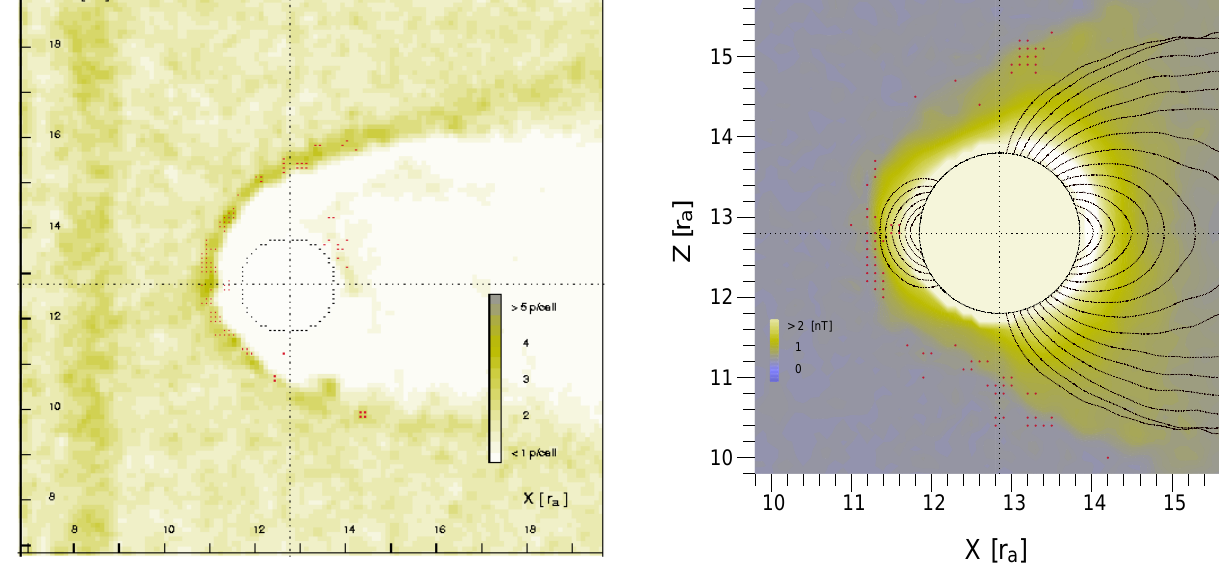
Fig. 2. Distribution of the magnetic induction intensity, B in the noon-midnight plane, at t =1s. Magnetic field lines are overplotted in black and grid points, where the level of the current density is above 9nA/m 2 , are plotted in red.